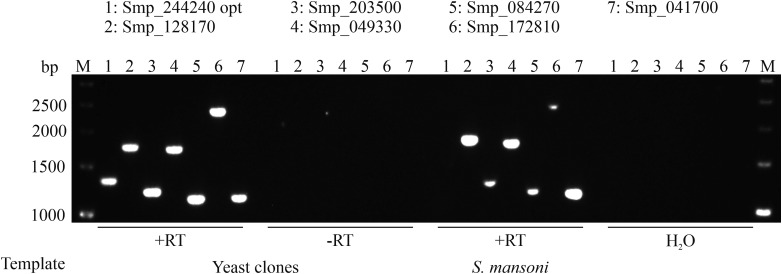
Full-length expression of S. mansoni GPCRs in S. cerevisiae. Wild type or optimized CDSs of GPCRs were transformed into yeast strain AH109. RNA was isolated and transcribed into cDNA. Specific primer pairs were used to amplify corresponding GPCRs (numbers 1-7) by RT-PCR, and resulting amplicons were size-separated on a 1% agarose gel (M = marker, bp = base pair). The absence of reverse transcriptase (-RT) during cDNA synthesis or cDNA synthesis without template (H2O) served as negative controls. RNA isolated from S. mansoni served as a positive control for full-length transcripts. In each case, amplicons of the expected sizes were obtained.